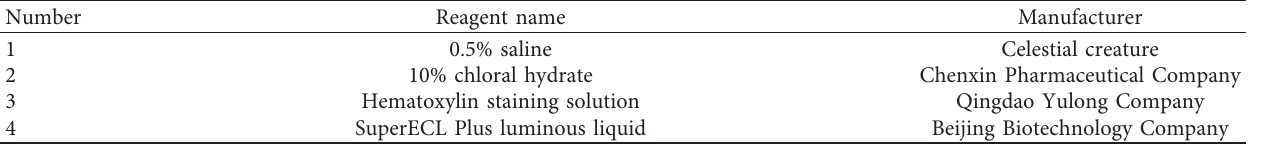
Table 1: Experimental reagents and names used in the